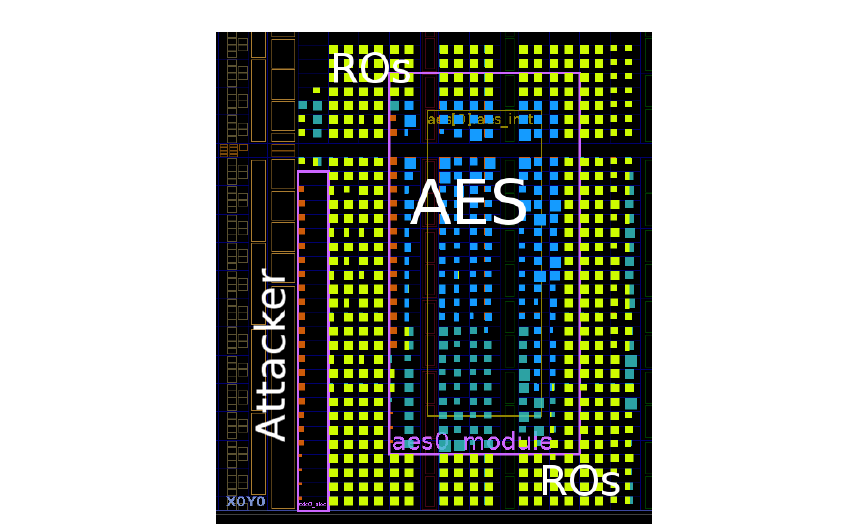
Figure 5: Floorplan of our rudimentary example countermeasure based on a randomly activated array of ROs (yellow) around the AES module (blue).